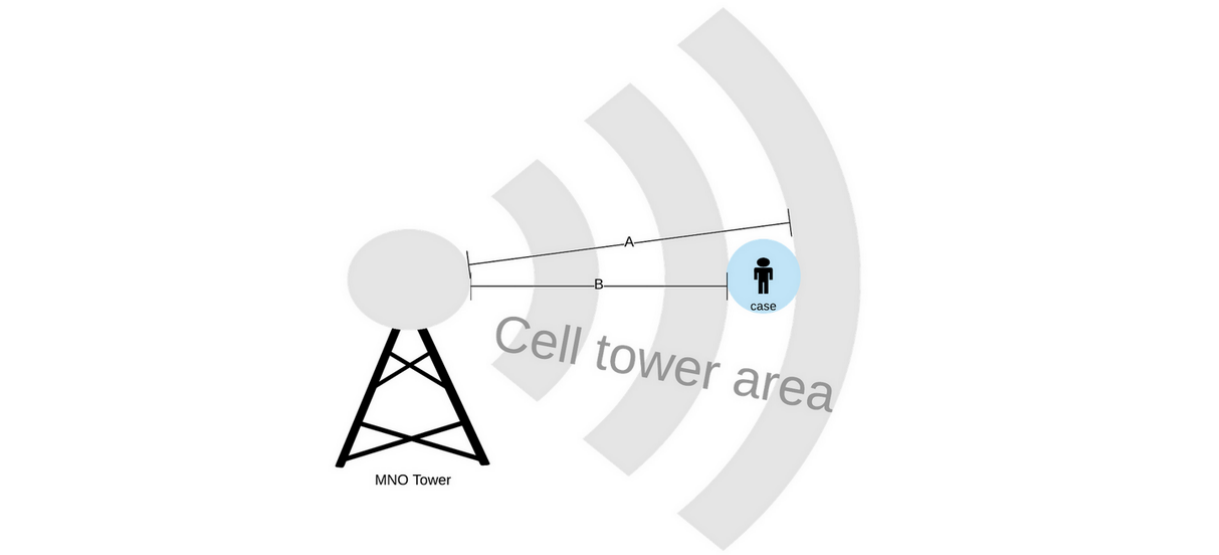
Figure 2. Location of a subject with respect to a mobile network operator (MNO) cell